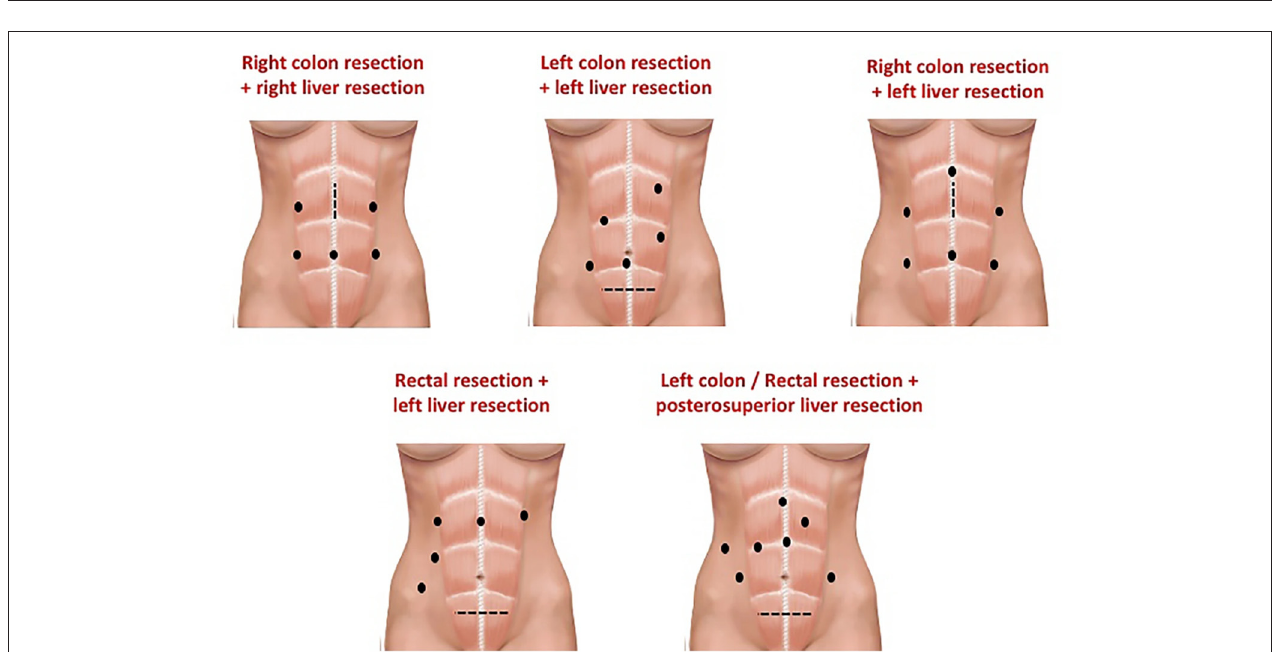
FIGURE 2 | Example of trocar placement to perform a combined resection. From Rocca et al. (31).